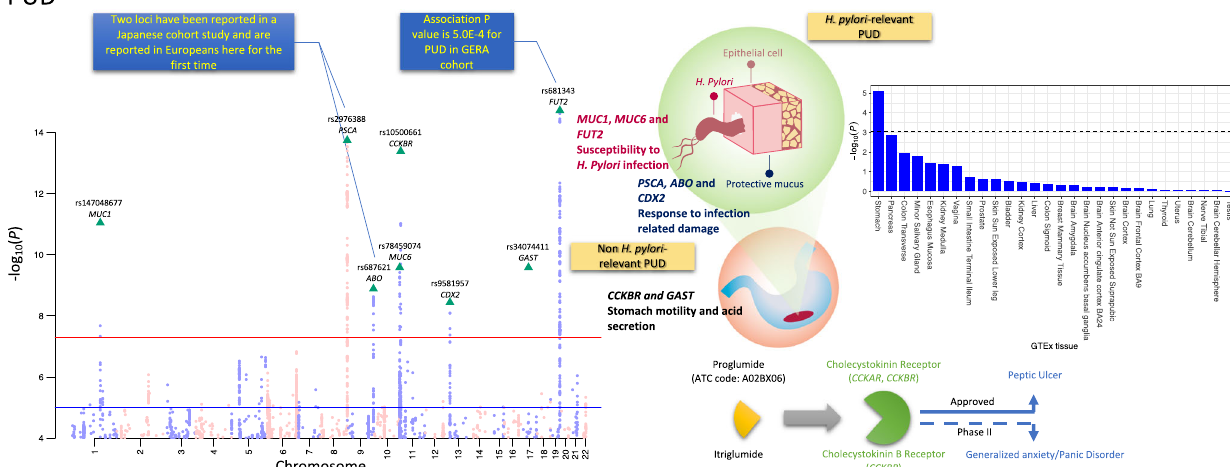
Fig. 2 Manhattan plot of peptic ulcer disease (PUD) for SNPs associated P < 1.0E − 4 from BOLT-LMM association test. SNPs highlighted with green triangles are independent loci with P < 5.0E − 8. rs2976388 and rs687621 are the only two loci associated with duodenal ulcer in a Japanese cohort 18 and rs681343 showed statistically signi fi cant association in GERA PUD GWAS, as annotated in the blue box. SNPs on odd/even chromosomes are presented in mauve/pink. Schematic diagram on the right side represents the reported biological evidence supporting involvement in peptic ulcers of genes physically located near PUD-associated loci (noting that we do not have direct evidence to link the associated SNPs with the genes). MUC1 76 , MUC6 77 , and FUT2 73 have been linked to susceptibility to H . pylori infection and PSCA and ABO have been proposed to be associated with subsequent response after infection 18 . Induced/enhanced CDX2 expression as a result of H. pylori infection of gastric epithelial cell lines has been observed 79 . GAST encodes gastrin, which is a hormone whose main function is to stimulate secretion of hydrochloric acid by the gastric mucosa. CCKBR encodes cholecystokinin receptor which mediates a therapeutic effect for peptic ulcer treatment by reducing acid secretion and inhibiting gastrointestinal motility. The cholecystokinin receptor is also an effect-mediating target of itriglumide on phase II clinical trial for anxiety and panic disorder 81 . Using the GENE2FUNC of FUMA pipeline 38 , we found that the eight annotated genes are highly overexpressed in human stomach tissue from GTEx 8th version data, as shown in the bar plot on the right side with data presented in Supplementary Data 2. The dashed line represents Bonferroni corrected signi fi cance at − log 10 Figs. 4 – 8. Detailed pleiotropy results derived from the GWAS Catalog 39 are provided in Supplementary Data 1. The 54 GTEx tissue speci fi c enrichment results for eight genes in Fig. 2 are in Supplementary Data 2. In sensitivity analysis GWAS, phenotypes for each of PUD, GORD, IBS, and IBD were regenerated by excluding individuals with more than one GI diagnosis among these four disorders from the corresponding original phenotype cases (Supplementary Note 3).